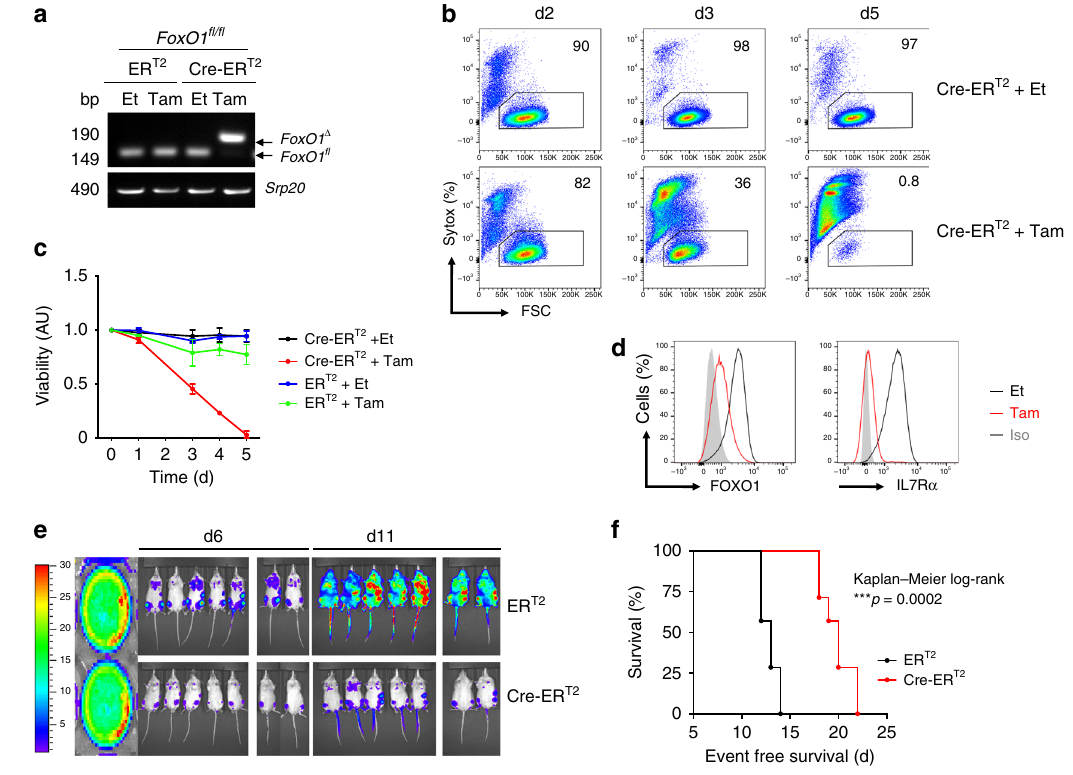
Fig. 6 FoxO1 is required for BCR-ABL1 driven leukemogenesis. FoxO1 fl / fl pre-B cells were transformed with BCR-ABL1 and were then transduced with Cre- ER T2 . Cells were treated with either tamoxifen (Tam) to induce Cre expression, or with ethanol (Et). a PCR analysis for FoxO1 deletion ( FoxO1 Δ ), Srp20 was used as a loading control. Cells transduced with ER T2 were used as control. bp base pair. b The percentage of living cells were determined by fl ow cytometry using Syotx as excluding dead cell stain. c The fold change of living cells after treatment with either Et or Tam at different time points. N = 3 independent samples per group, and error bars represent mean ± SD. One-way ANAOVA. Dunnett ’ s multiple comparisons test was performed to day 5, compared with control group (ER T2 Et). Adjusted p values: ER T2 Et vs. ER T2 Tam * p = 0.0251, ER T2 Et vs. Cre-ER T2 Et n.s. p > 0.9999, ER T2 Et vs. Cre-ER T2 Tam **** p < 0.0001. AU arbitrary unit. d Intracellular staining for FOXO1 protein (left) and an extracellular staining of IL7R (right) after 72 h of Cre- induction. The results are representative of three independent experiments. e Luciferase bioimaging and f Survival curves of mice that were injected with 1 × 10 6 FoxO1 fl / fl cells that had been transformed with BCR-ABL1 and transduced with either a Cre-ER T2 construct or an empty vector control (ER T2 ). Cells were labeled with luciferase and injected into NOD-SCID mice. ( n = 14 per group). Mantel – Cox-log-rank test, ***p =